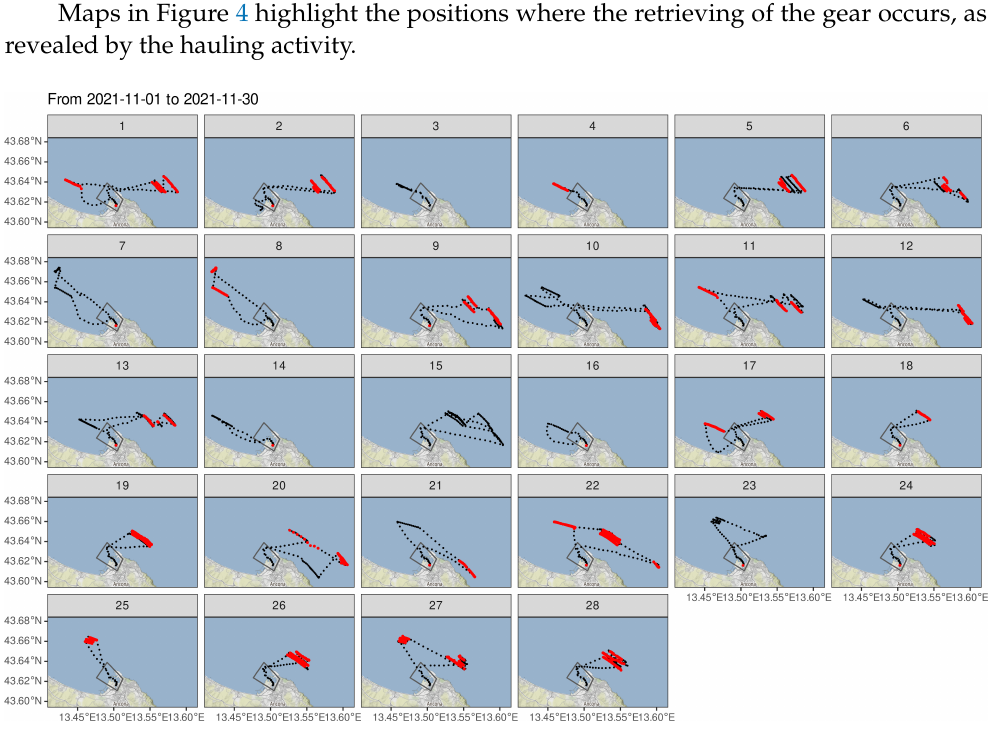
Figure 4. Identified port-to-port trips and sensor activity (red points). The geofence area is represented by the gray solid